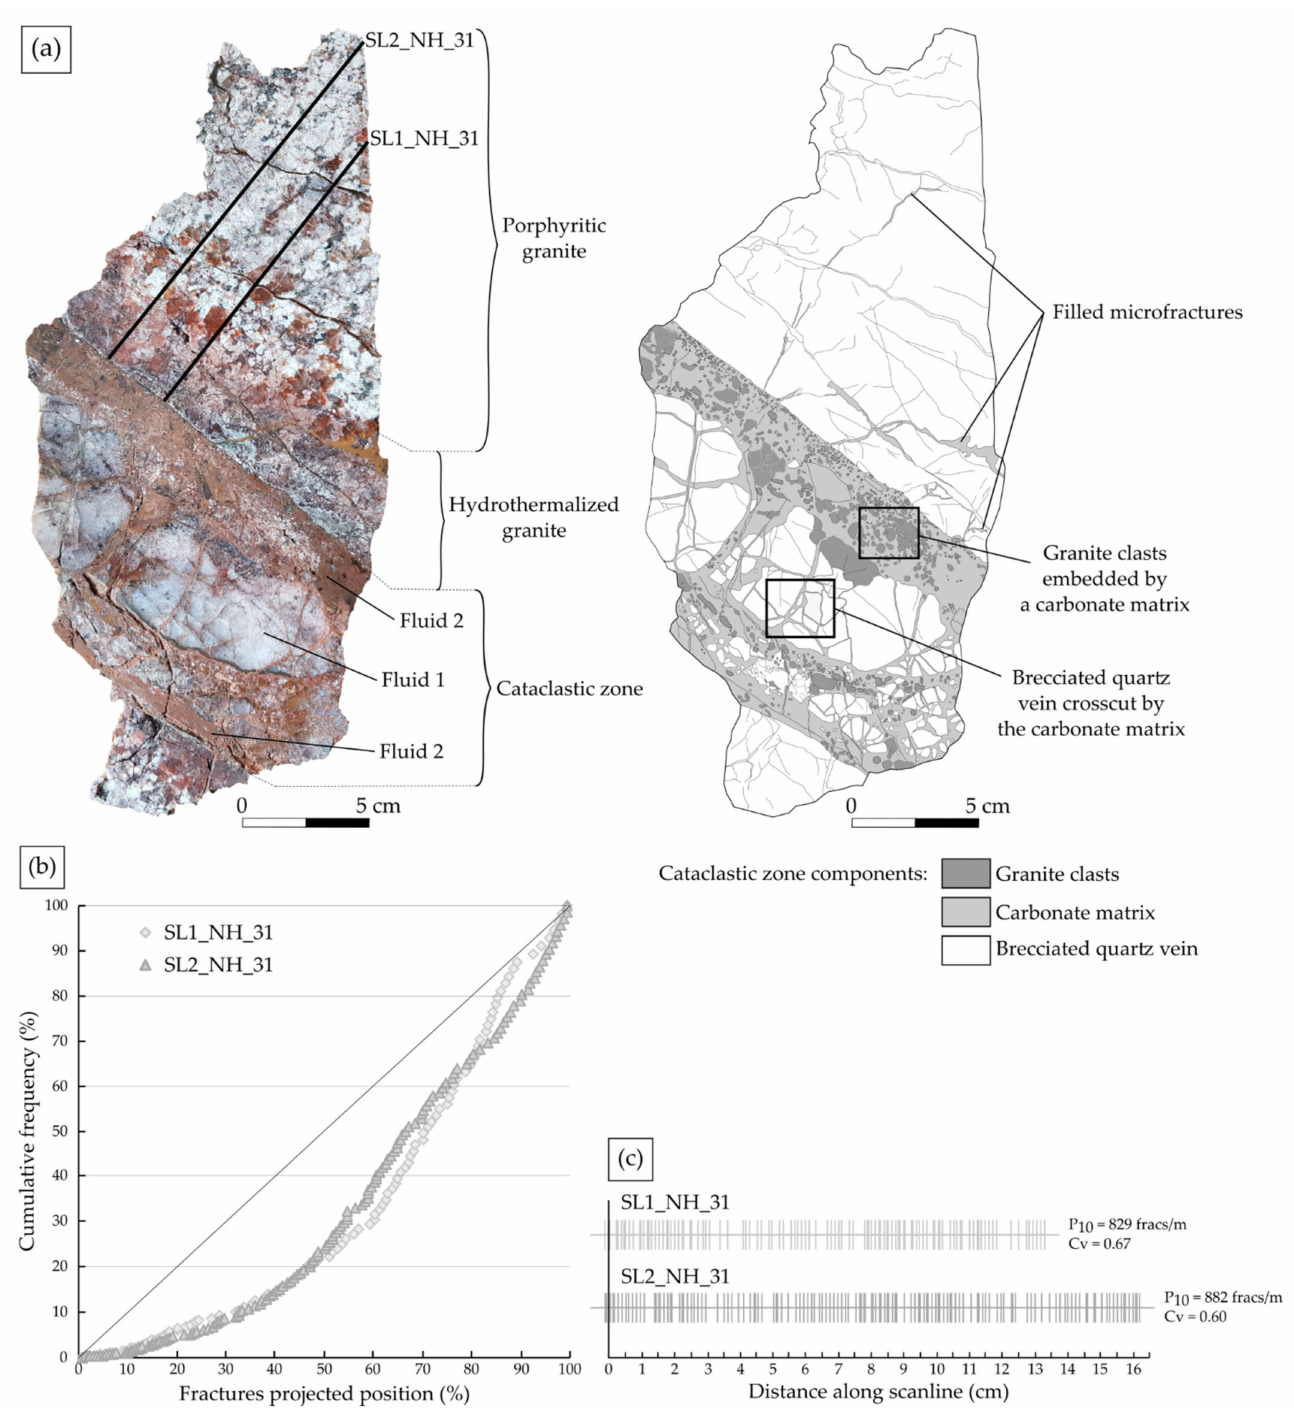
Figure 7. ( a ) Photo and the respective digitalization of the sample NH_31, gathering NH_31_1_2 and NH_31_3, showing the different compartments that compose it, as well as the two scanlines realized in the host rock of the vein. ( b ) Plots of the cumulative frequency percentage against distance percentage for both scanlines. The diagonal represents a uniform distribution. ( c ) Stick plots showing the fracture position along the scanlines and for which the fracture density (P 10 ) and the coefficient of variation (Cv) are